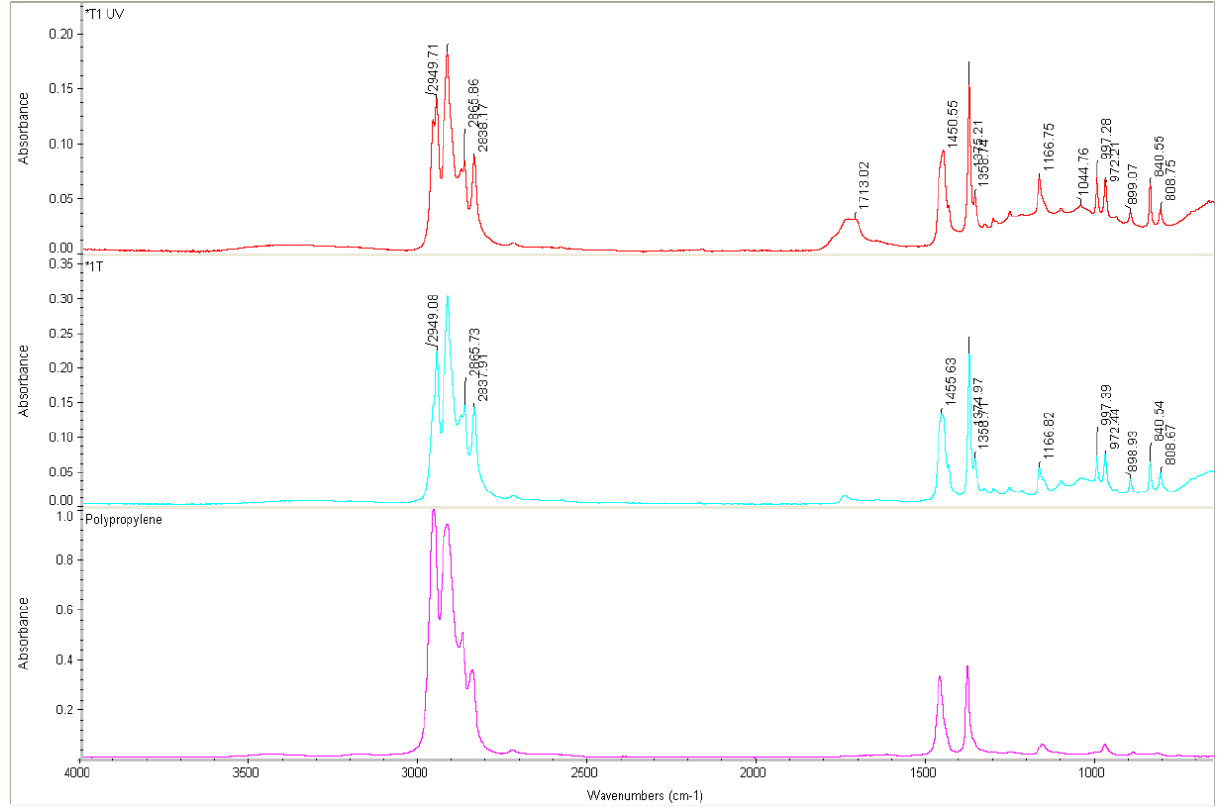
Figure 1: FTIR spectrums of the surface of unweathered and UVweathered WP composite (sample T-1): green of unweathered, red curve of weathered and violet of standard spectrum of